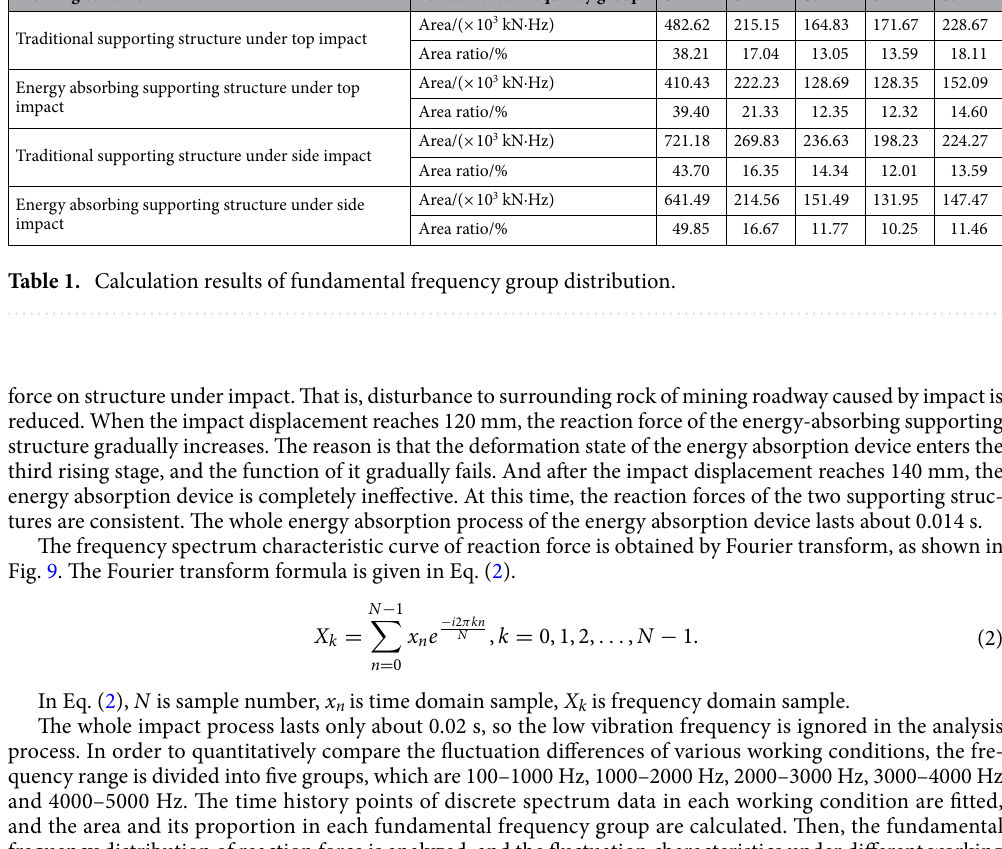
Figure 9. Frequency spectrum characteristic curve of reaction force.